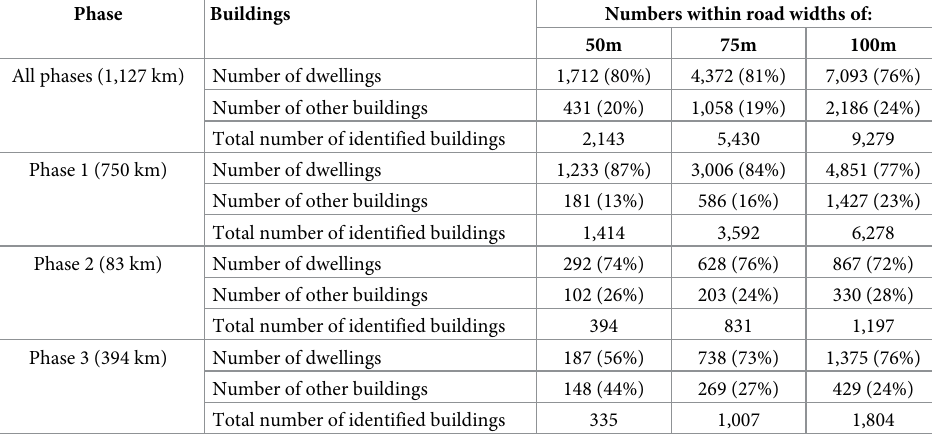
Table 1. Building numbers that may be impacted by the Pan Borneo